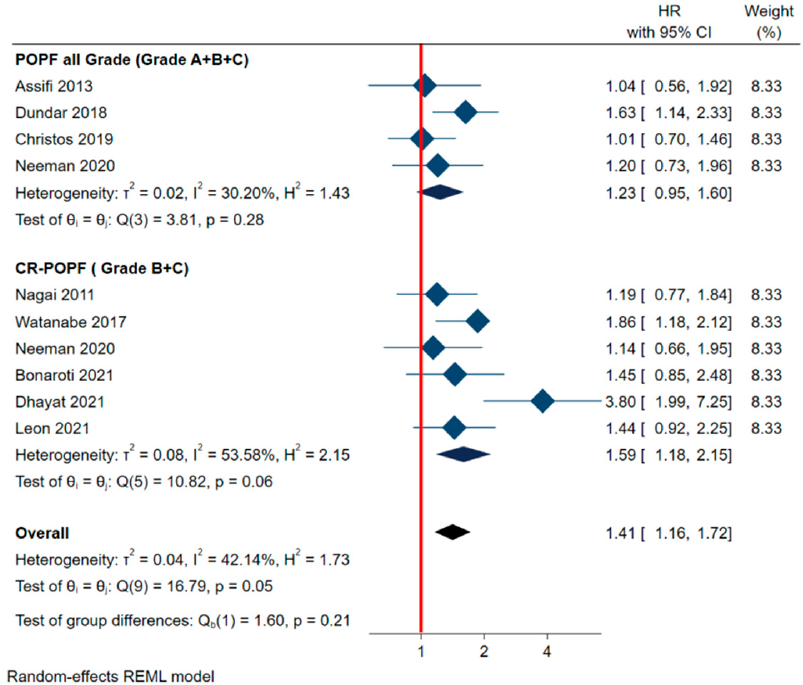
Figure 2. Forest plot summarizing the meta-analysis to compare disease-free survival in patients with and without postoperative pancreatic fistula (POPF) or clinically relevant postoperative pancreatic fistula (CR-POPF). HR: hazard ratio; 95% CI: 95% confidential interval.